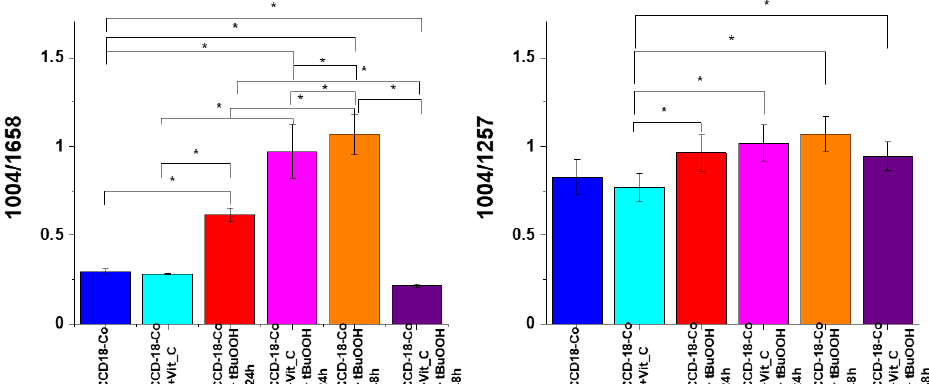
Figure 10. Raman band intensities ratios for selected Raman bands corresponding to proteins for 6 groups of normal human colon cells CCD-18 Co: control group (labeled CCD-18-Co, blue), group supplemented with vitamin C (labeled CCD-18 Co+Vit_C, turquoise), group supplemented with tBuOOH for 24h (labelled CCD-18 Co+tBuOOH, 24h, red), group supplemented with vitamin C and tBuOOH for 24h (labelled CCD-18 Co+Vit C+tBuOOH, 24h, magenta), group supplemented with tBuOOH for 48h (labelled CCD-18 Co+tBuOOH, 48h, orange), group. supplemented with vitamin C and tBuOOH for 48h (labelled CCD-18 Co +Vit C+tBuOOH, 48h, violet), the statistically significant results, based on ANOVA analysis, have been marked with asterix.